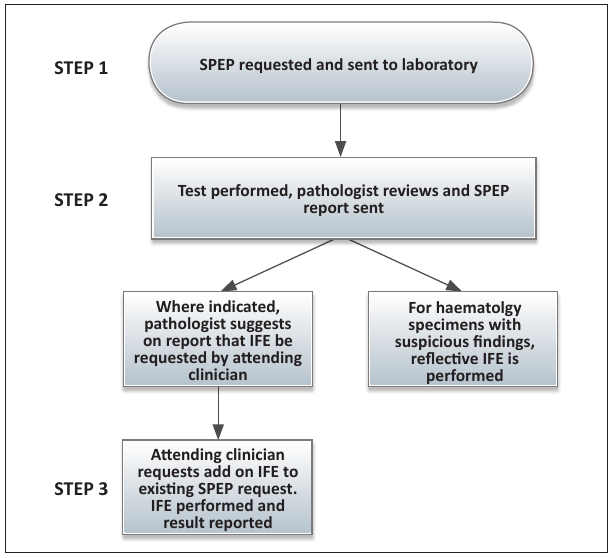
FIGURE 1: Flow diagram illustrating IALCH laboratory IFE requesting